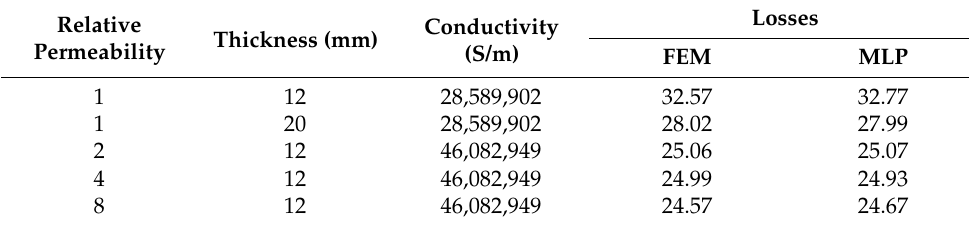
Table 4. Predicted eddy current losses of the test sample set (Kw).